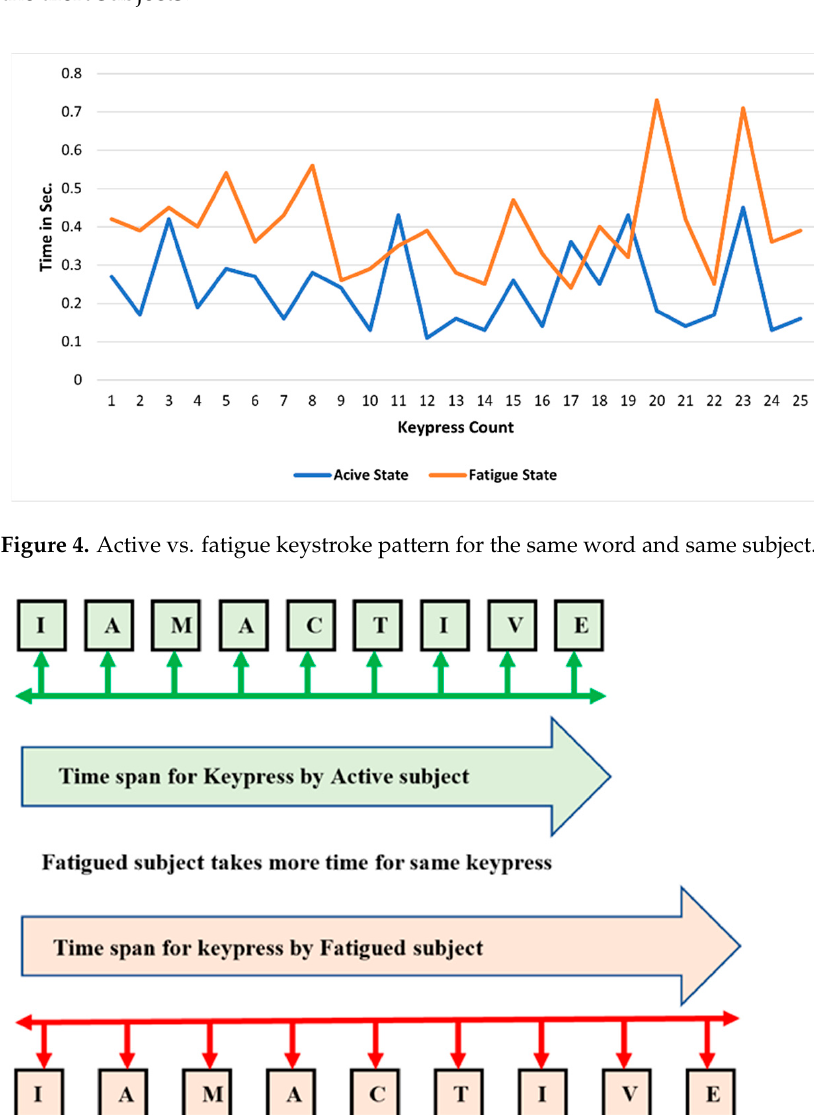
Table 3. List of features from keystroke dynamics.